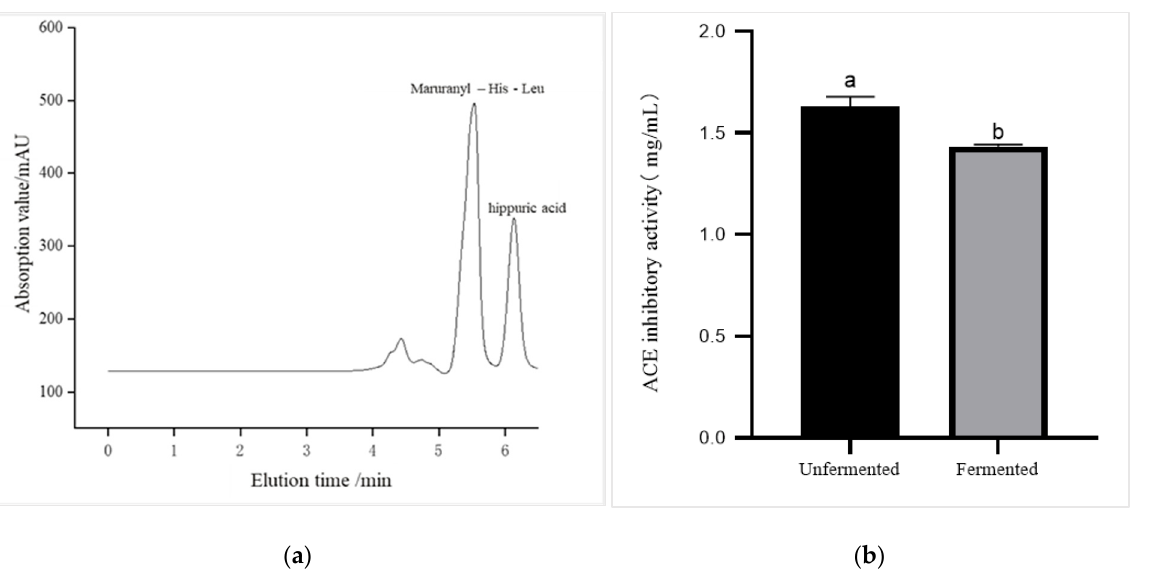
Figure 3. ( a ) HPLC diagram for assay of ACE inhibition activity. ( b ) Results of ACE inhibition activity in oyster fermentation liquid ( p < 0.05). Different lowercase letters in the figure indicate significant differences between values.